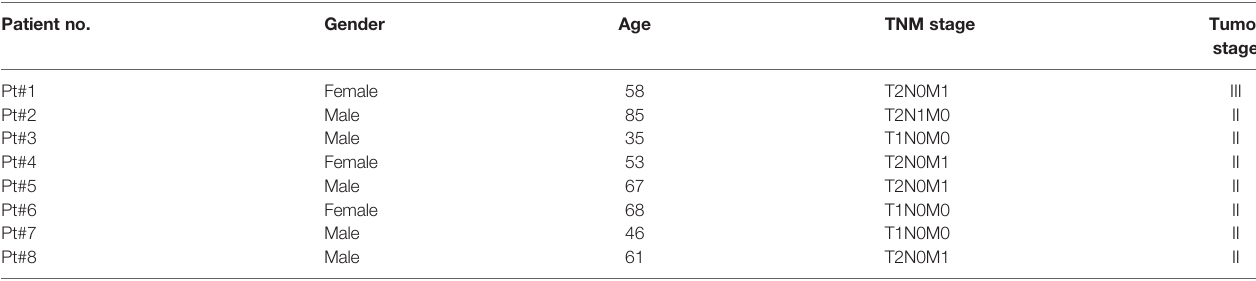
ccRCC, clear cell renal cell